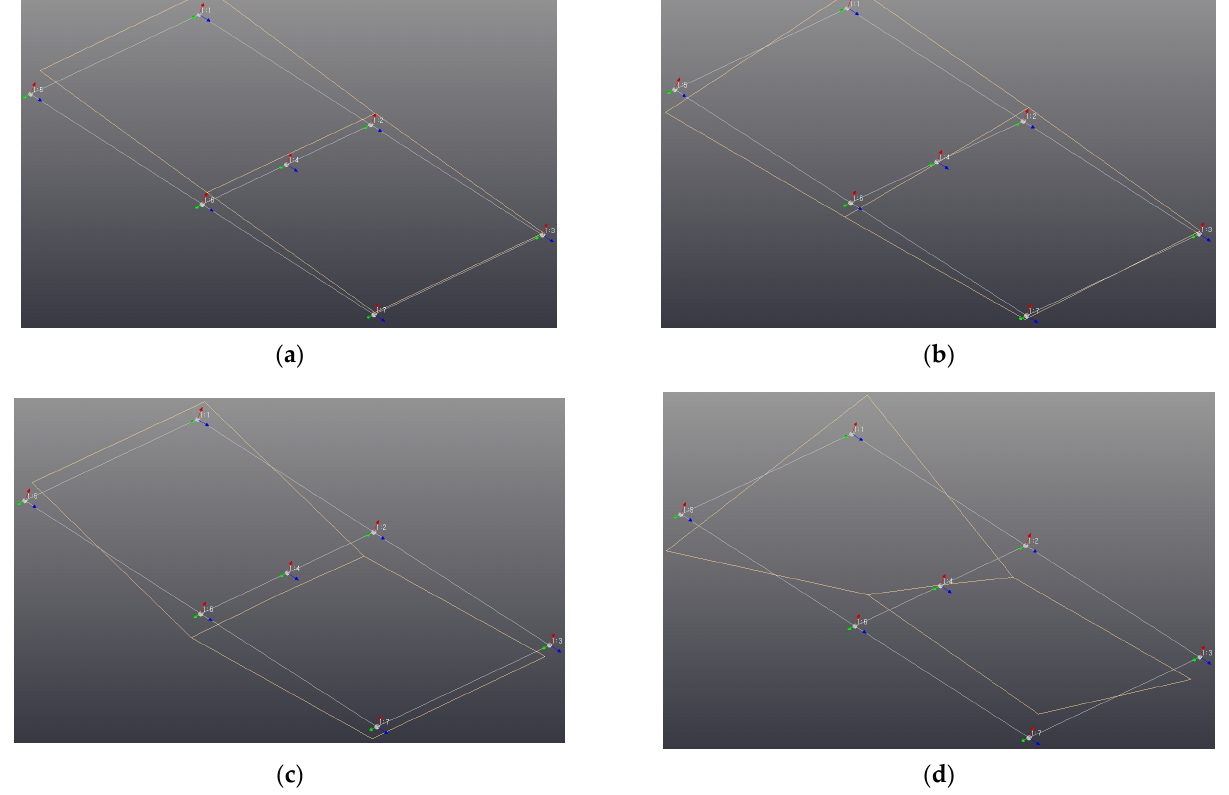
Figure 5. Experimental mode shape of simple specimens (yellow line) overlapped with the original model (white line): ( a ) first mode (1st bending); ( b ) second mode (1st twisting); ( c ) third mode (2nd bending); ( d ) fourth mode (2nd twisting).